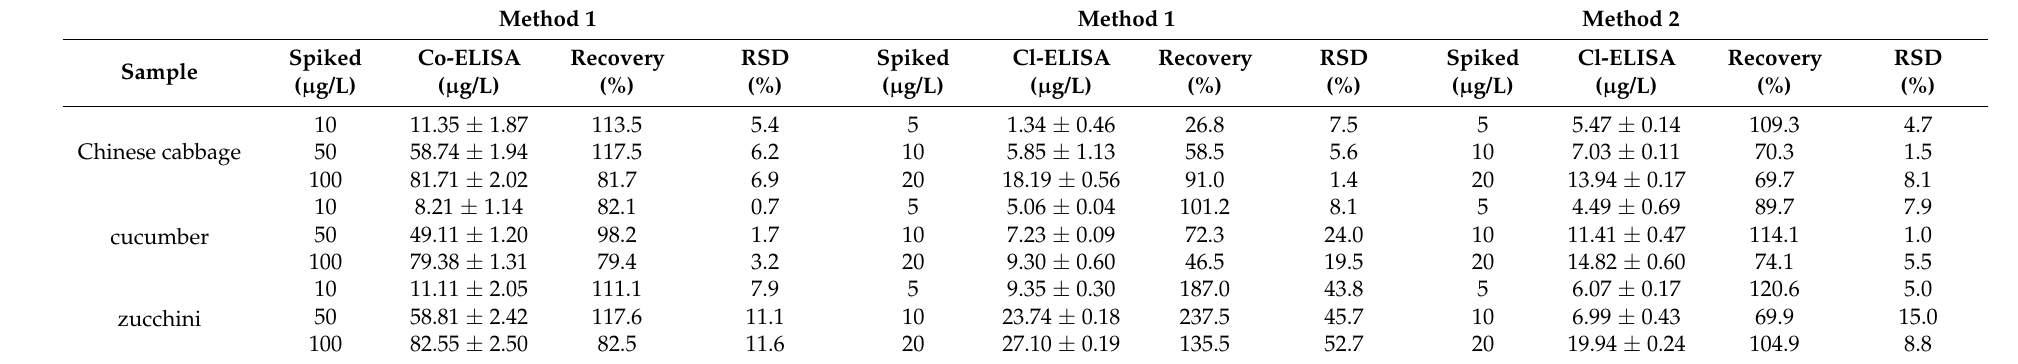
Table 4. Recovery of spiked IMI in vegetable samples (Chinese cabbage, cucumber, and zucchini) using Co-ELISA and Cl-ELISA (n =